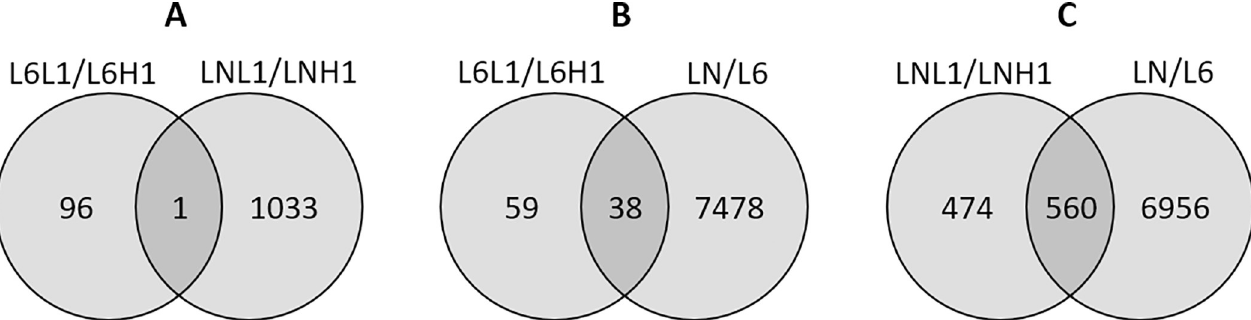
Fig 4. Venn diagram. Differentially expressed genes identified by comparing different groups of animals: (A) L6L1/L6H1 and LNL1/LNH1 (low vs high carriers of lines 6 1 and N, respectively, in experiment 1), (B) L6L1/L6H1 and LN/L6 (low vs high carriers of line 6 1 in experiment 1, and line N vs line 6 1 ), and (C) LNL1/LNH1 and LN/L6 (low vs high carriers of line N in experiment 1, and line N vs line 6 1 ).